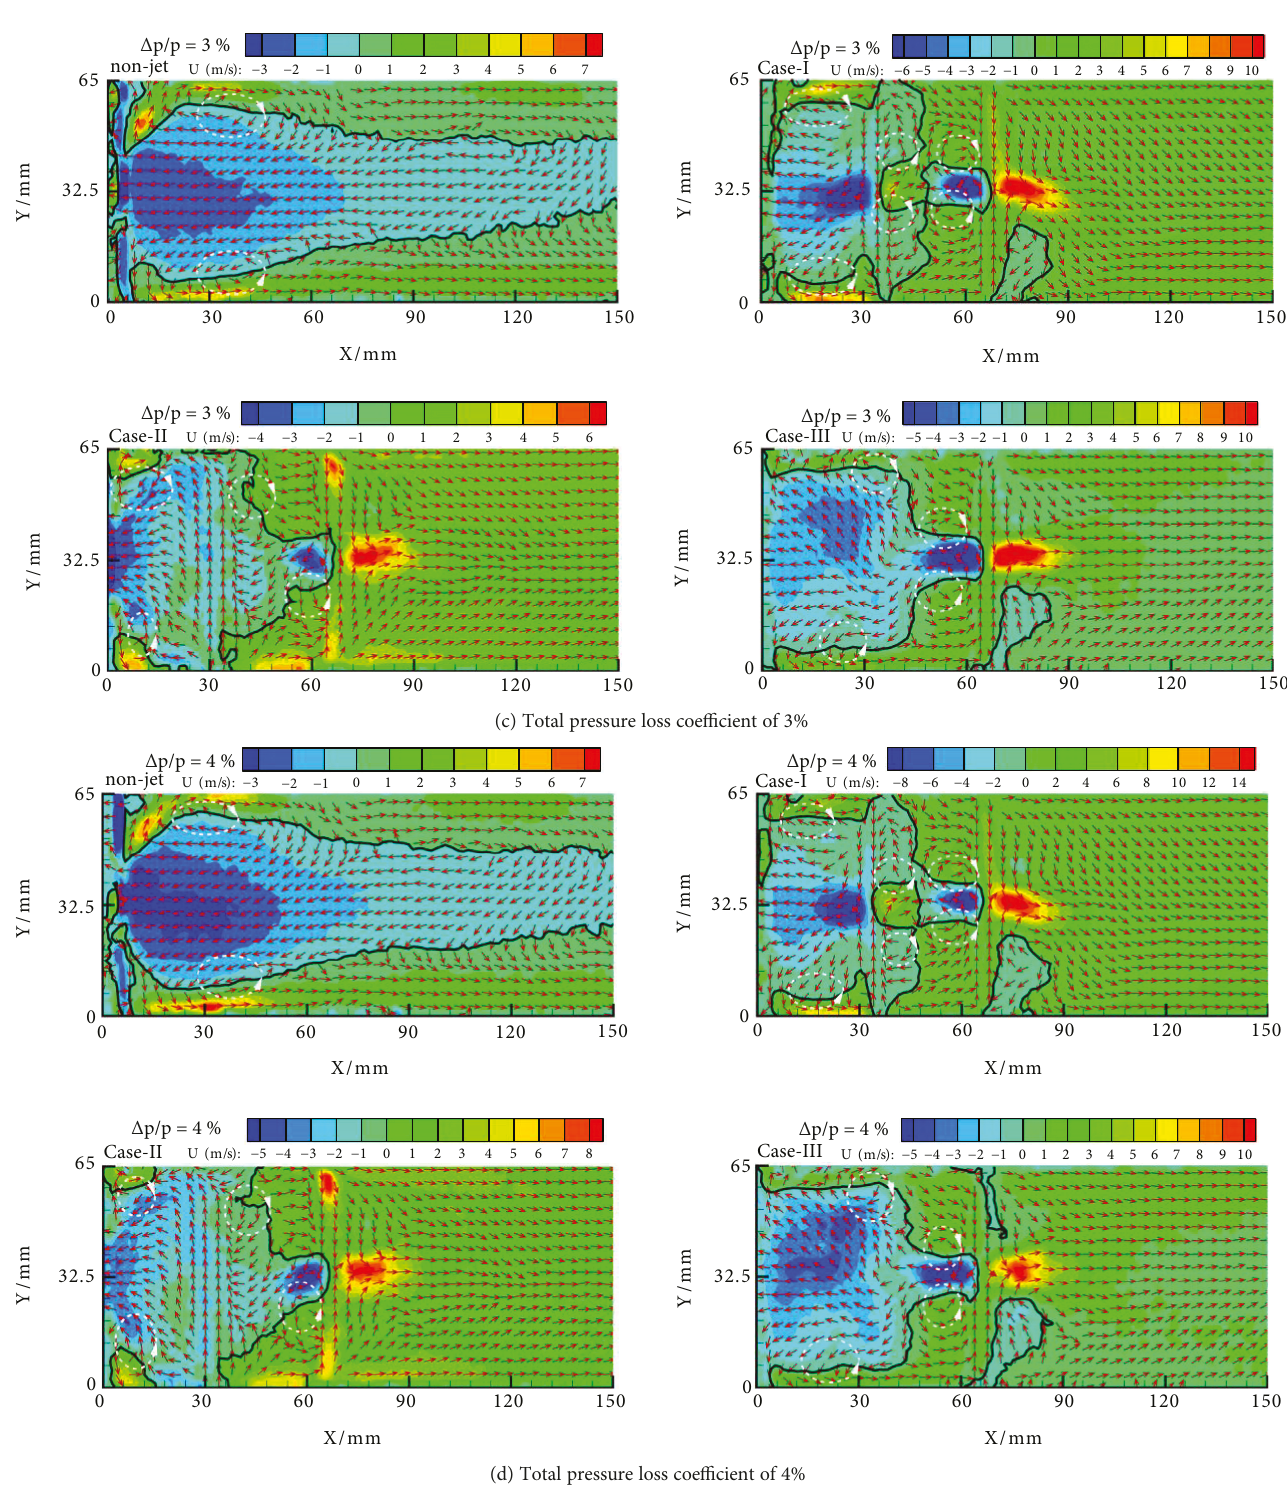
Figure 3: Axial velocity contours and velocity vector plots on the Z = 0 mm